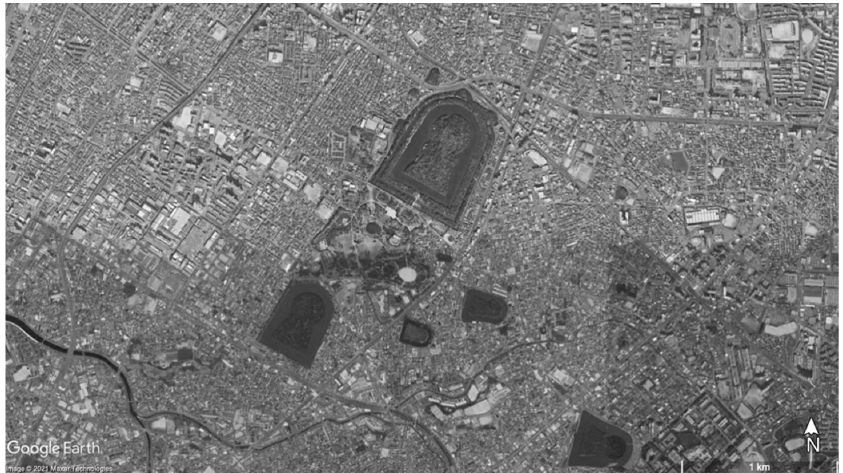
Figure 2. The Daisen Kofun with some of its satellites in the Mozu cluster (image courtesy of Google Earth).